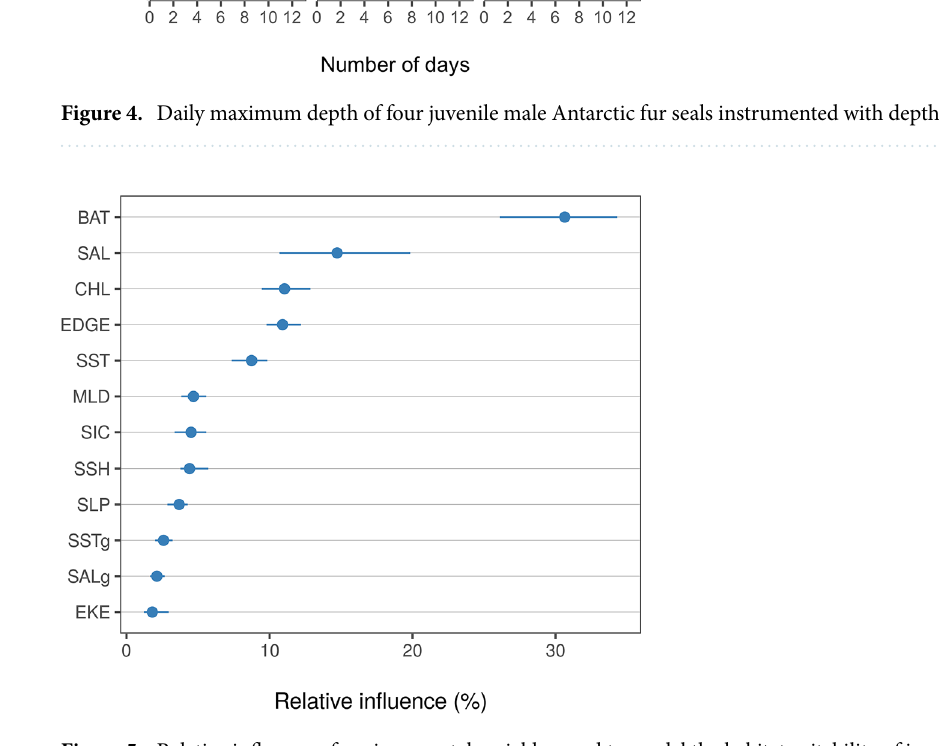
Figure 5. Relative influence of environmental variables used to model the habitat suitability of juvenile and sub-adult Antarctic fur seals. Dots represent medians and lines represent the 95% confidence interval range of the bootstrap predictions (n = 50). BAT: bathymetry, SAL: salinity, CHL: log-transformed (x + 1) concentration of chlorophyll-a, EDGE: distance from the sea ice limit, SST: sea surface temperature, SIC: sea ice fraction, SSH: sea surface height, MLD: mixed layer depth, SLP: slope, SSTg: sea surface temperature gradient, SALg: salinity gradient, EKE: eddy kinetic